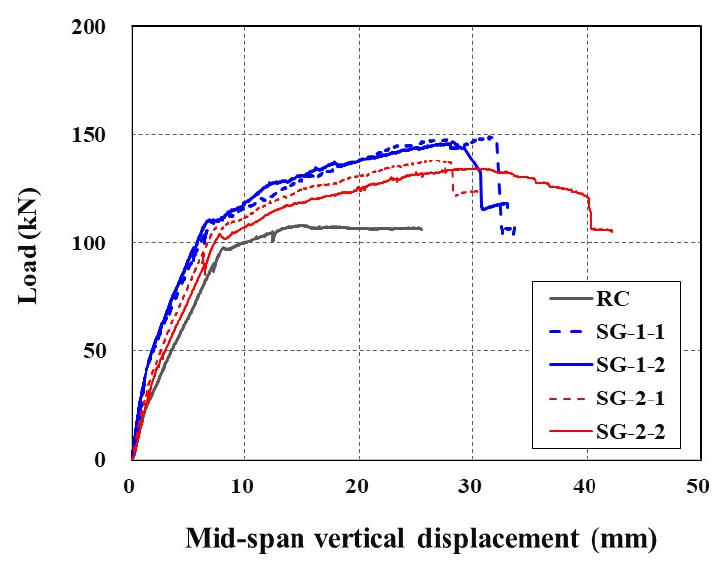
Figure 8. Load ‐ displacement curves of